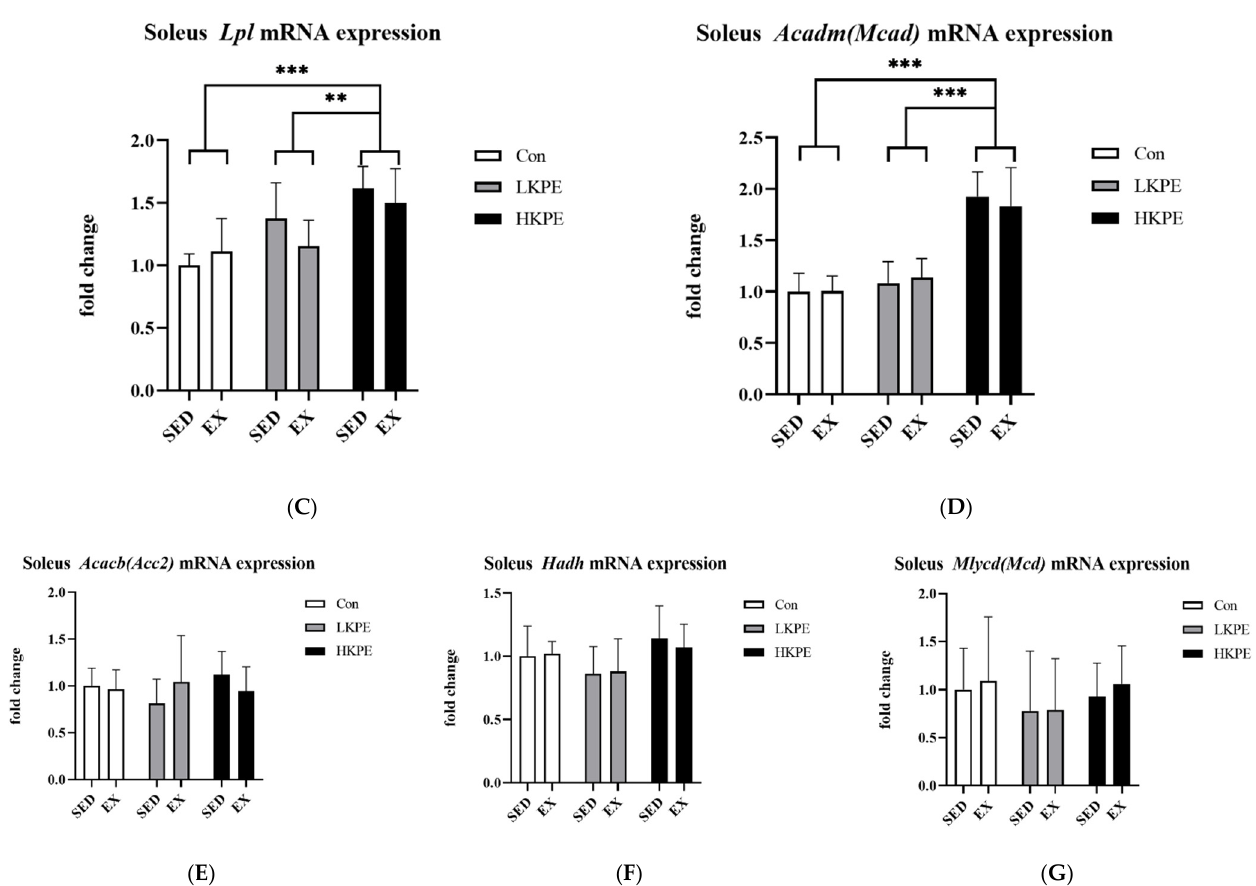
Figure 3. mRNA expression of ( A ) Pnpla2 (Atgl) , ( B ) Aco , ( C ) Lpl , ( D ) Acadm (Mcad) , ( E ) Acacb (Acc2) , ( F ) Hadh , and ( G ) Mlycd (Mcd) in soleus muscle immediately after exhaustion. Lpl , lipoprotein lipase; Pnpla2 (Atgl) , patatin-like phospholipase domain containing 2; Aco , acyl-CoA oxidase; Acadm (Mcad) , acyl-Coenzyme A dehydrogenase medium chain; Hadh , hydroxy acyl-CoA dehydrogenase; Acacb (Acc2) , acetyl-Coenzyme A carboxylase beta; Mlycd (Mcd) , malonyl-CoA decarboxylase; SED, sedentary; EX, exercise; Con, control; KPE, Kaempferia parviflora administration; ns, no significance observed; * p < 0.05, ** p < 0.01, *** p < 0.001.